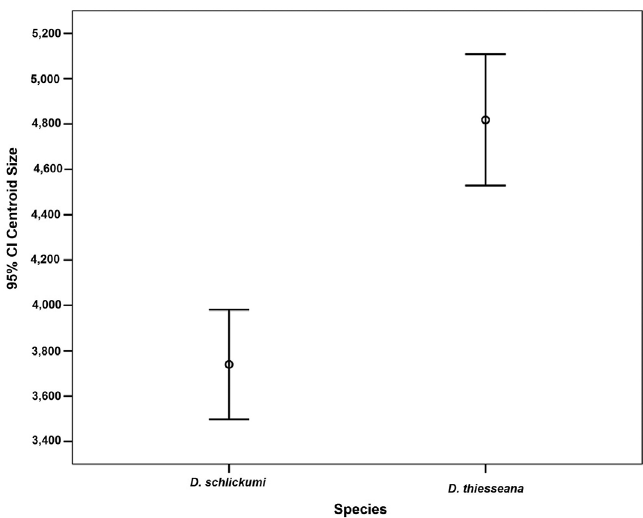
Figure 8. Means ± 95% Confidence Intervals of centroid size for the two Dianella species and their ordinations based on landmark